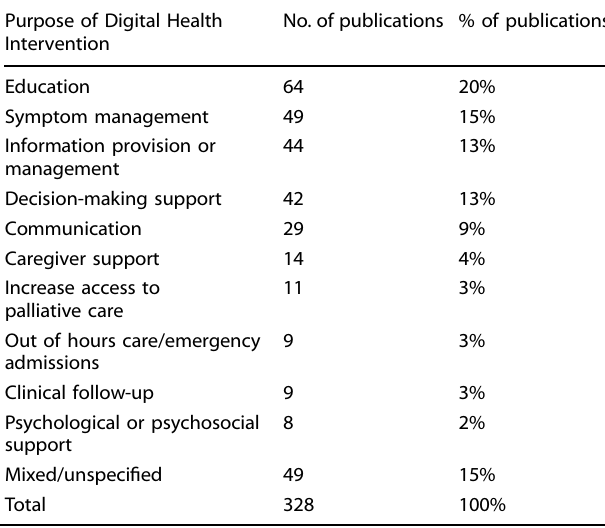
Table 2. Main purpose of DHIs reported in publications included in 21